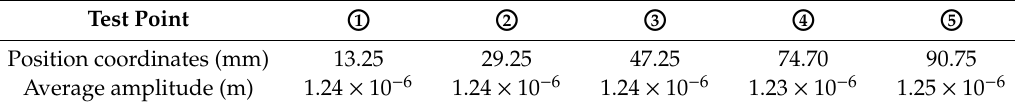
Figure 14. Vibration waveform test results of five test points. ( a ) Waveform results of test point ① ; ( b ) Waveform results of test point ② ; ( c ) Waveform results of test point ③ ; ( d ) Waveform results of test point ④ ; ( e )Waveform results of test point ⑤ . Table 3. Position coordinates and average amplitude of five test